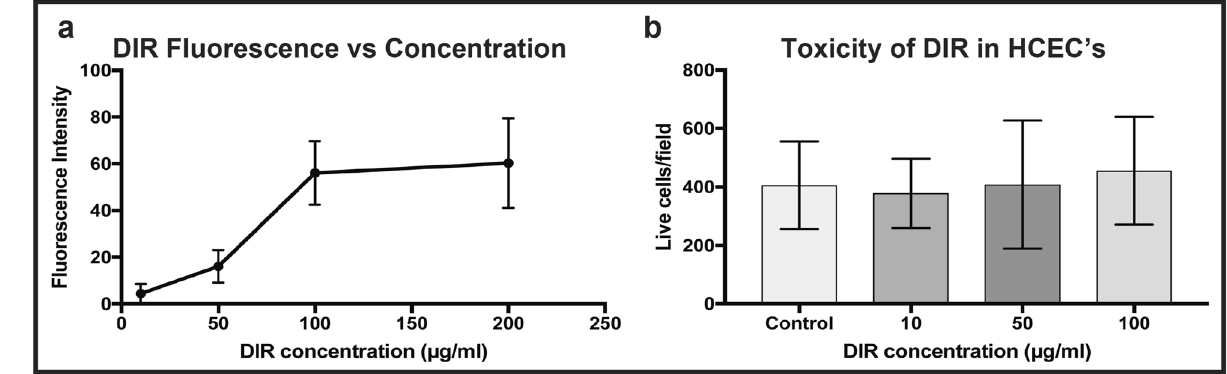
Figure 1. Optimization of DIR concentration in vitro. ( a ) Graph showing average (mean and standard deviation) DIR fluorescence in human CECs as a function of concentration. ( b ) Bar graph comparing toxicity of DIR at different concentrations in cells derived from the same donor cornea (n = 6) per